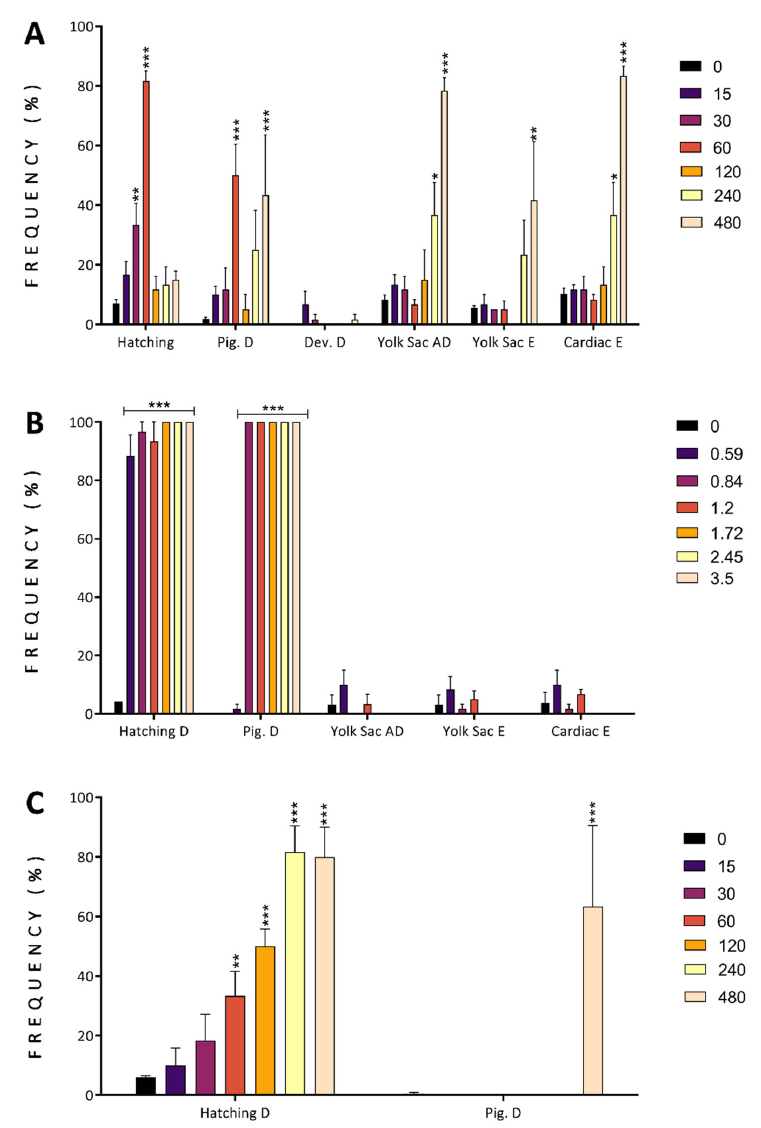
Figure 5. Developmental alterations observed in organisms exposed at 96 h post-fertilization to different concentrations of finger lime ( A ), mountain pepper ( B ), and tamarind ( C ) extracts. The alter- ations observed were hatching delay (Hatching D), pigmentation delay (Pig. D), developmental delay (Dev. D), yolk sac absorption delay (Yolk Sac AD), yolk sac edema (Yolk Sac E), and cardiac edema (Cardiac E). Bar colours represent the concentration tested in mg/L. Data represent the mean ± SD, n = 60. Asterisks indicate statistical significance when comparing the exposed groups with the control groups: p < 0.05 (*), p < 0.01(**) and p < 0.001